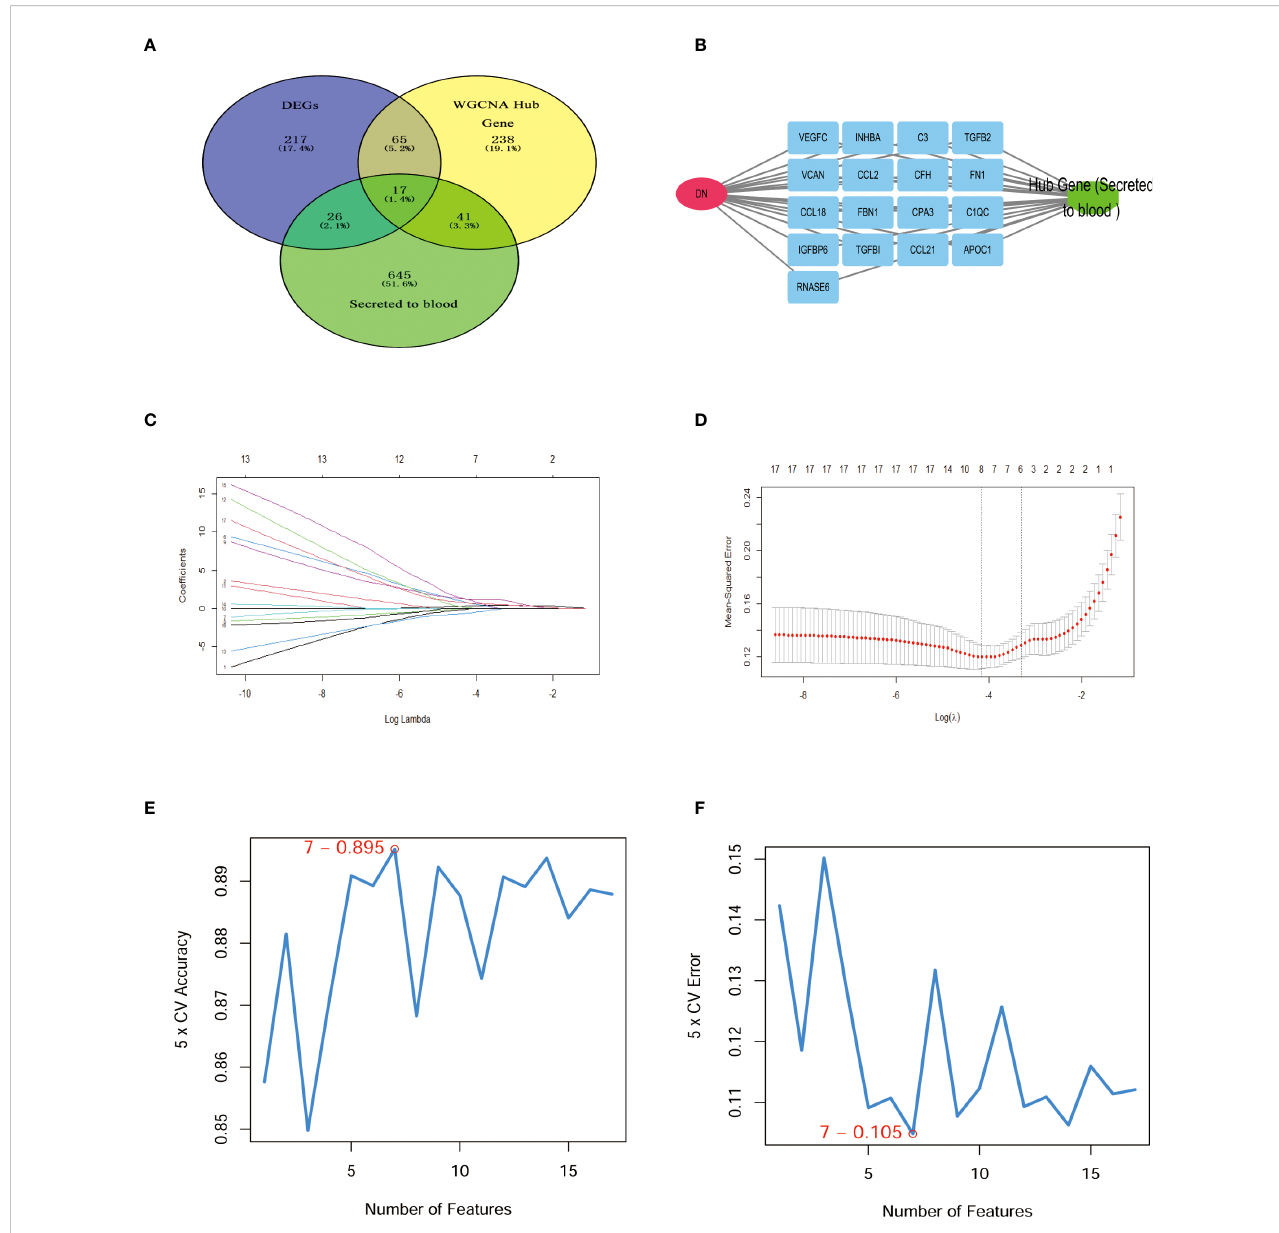
FIGURE 4 Hub secret genes selection in DN. (A) Venn diagram demonstrating the hub genes for the different algorithms. (DEGs, WCANA, and secreted to blood genes). (B) 17 characteristically secret genes in DN patients. (C, D) Biomarker secret genes were selected by Lasso algorithm from the 17 potential hub genes. (E, F) Biomarker secret genes were detected for DN by SVM-RFE algorithm from the 17 potential hub genes (the accuracy and the error rate of the SVM model). Lasso, Least absolute shrinkage and selection operator; SVM-RFE, support vector machine recursive feature